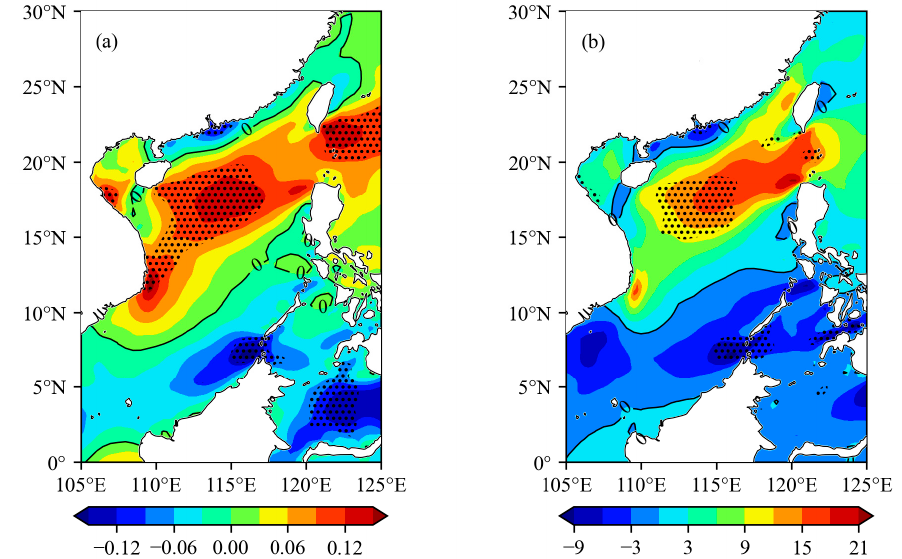
Figure 5. The linear variation trends of the annual mean wind (a, unit: m ‧ s − 1 ‧ (10a) − 1 ) and wind power density (b, unit: W ‧ m − 2 ‧ (10a) − 1 ) over the SCS from 1979 to 2021. The black dots indicate the significant areas with more than a 95% confidence level (which was achieved by using Student’s t -test).